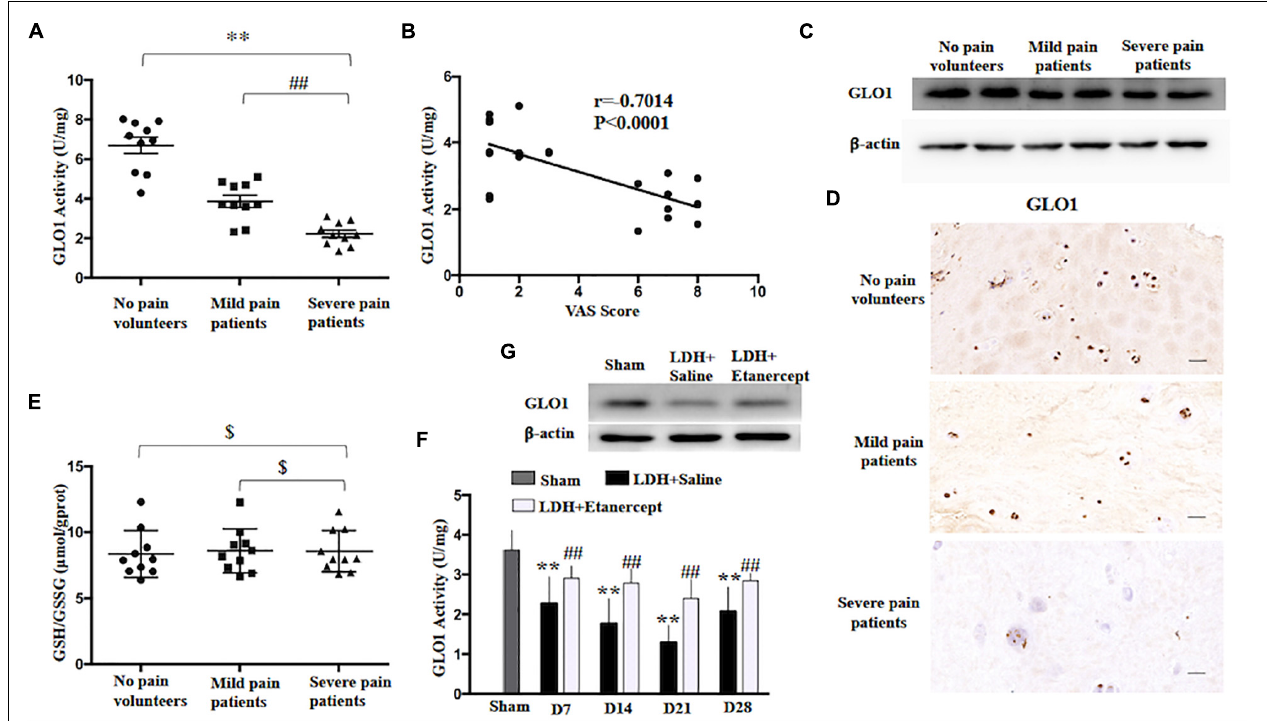
FIGURE 2 | Glyoxalase 1 (GLO1) activity decrease contributes to excessively accumulation of MG in herniated disc. (A) GLO1 activity was evaluated in herniated disc of the patients or volunteers (one-way ANOVA: F = 51.276, p < 0.001; post hoc Bonferroni: ∗∗ p < 0.001, volunteers with no pain vs. patients with severe pain. ## p = 0.003 patients with mild pain vs. patients with severe pain, n = 10). (B) The analysis of linear correlation between VAS and herniated disc GLO1 activity in patients. (C,D) Representative immunoblotting and immunohistochemistry showed the downregulation of GLO1 in herniated disc of patients. (E) GSH/GSSG was evaluated in herniated disc of the patients or volunteers (One-way ANOVA: F = 0.062, $ p = 0.94 > 0.05. n = 10). (F) The GLO1 activity of exposed NP was evaluated at different time points, following NP implantation (one-way ANOVA: F = 13.986, p < 0.001. Post hoc Bonferroni: sham vs. LDH + Saline at 14 days and 21 days: ∗∗ p < 0.001, at 7 days: ∗∗ p = 0.003, at 28 days: ∗∗ p = 0.001. One-way ANOVA, LDH + Etanercept vs. LDH + Saline: F = 8.116, ## p = 0.017 at 7 days; F = 12.039, ## p = 0.006 at 14 days; F = 17.944, ## p = 0.002 at 21 days; F = 8.866, ## p = 0.014 at 28 days. n = 6). (G) Representative immunoblotting showed the downregulation of GLO1 in exposed NP of rats on Day 14 after NP